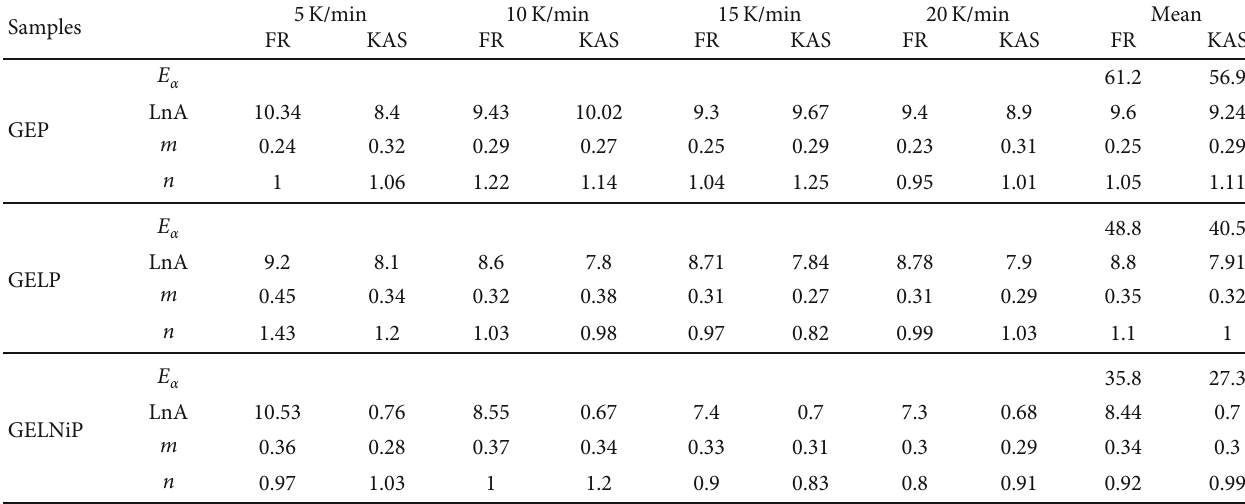
Table 1: The kinetic parameters of the curing of GEP, GELP, and GELNiP based on the FR and KAS model at various heating rates.